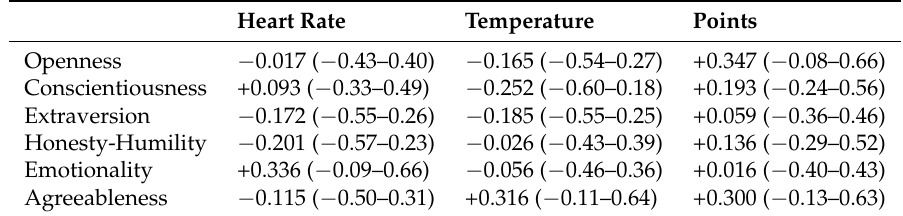
Table 5. Correlations between personality traits and the objective cognitive load measure for the Snake dataset with 95% confidence interval in